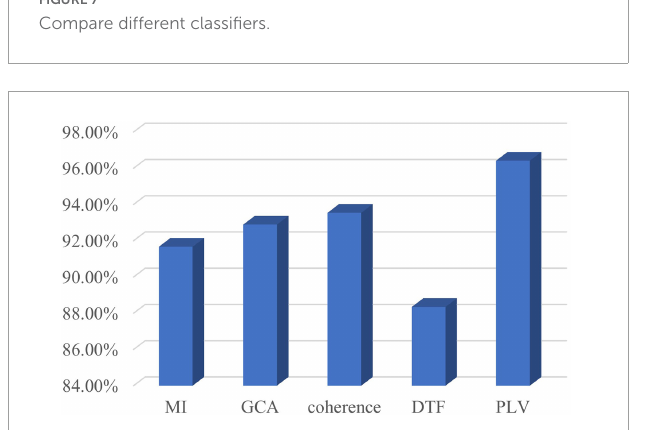
FIGURE8 Compare different connection methods. TABLE 6 Sleep classification results after cross-validation.